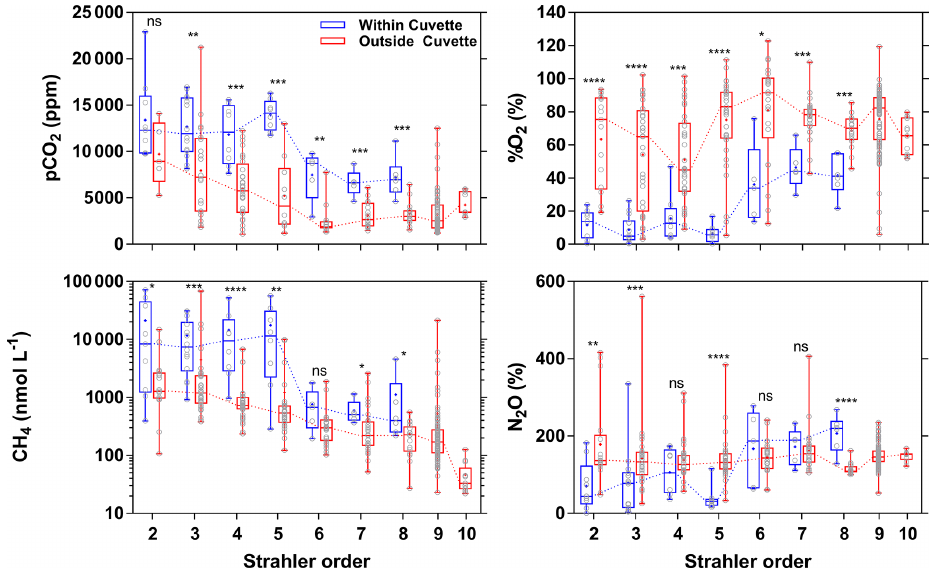
Figure 11. Box plot as a function of Strahler stream order of the partial pressure of CO 2 ( p CO 2 in ppm), dissolved CH 4 concentration (nmolL − 1 ), dissolved N 2 O saturation level (%N 2 O in %), and dissolved O 2 saturation level (%O 2 in %) for rivers and streams of the Congo River network draining and not draining the Cuvette Centrale Congolaise. The box represents the first and third quartile, the horizontal line corresponds to the median, the cross corresponds to the average, the error bars correspond to the maximum and minimum, and the symbols show all data points. A Mann–Whitney test was used to test statistical differences: ns represents not significant, ∗∗∗∗ = p< 0 . 0001; ∗∗∗ = p< 0 . 001; ∗∗ = p< 0 . 01; ∗ = p< 0 .